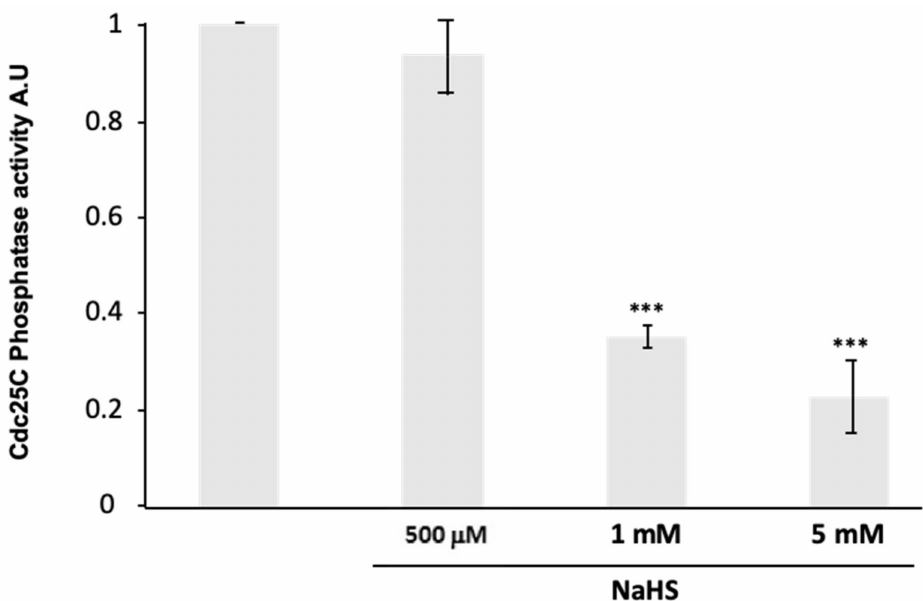
Figure 7. NaHS impairs human Cdc25C activity in vitro. The reactions were performed using 1 µ g of human recombinant Cdc25C pre-incubated or not with NaHS (500 µ M, 1 mM, or 5 mM). Results are shown as relative ratios to control without NaHS. Statistical significance was accepted for *** p < 0.001. Three independent experiments were